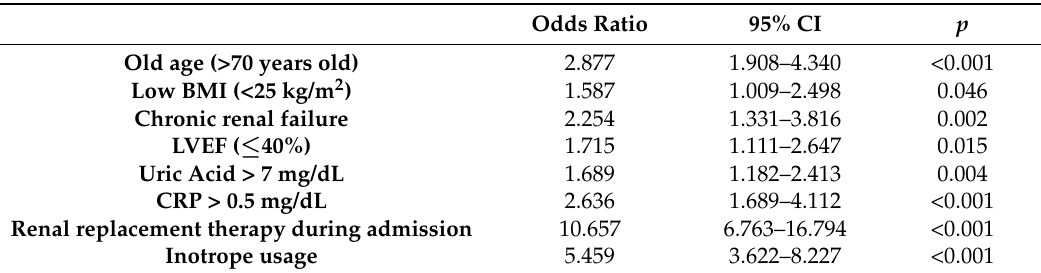
Table 3. Independent predictors of in-hospital clinical outcomes. BMI, body mass index; LVEF, left ventricular ejection fraction; CRF, chronic renal